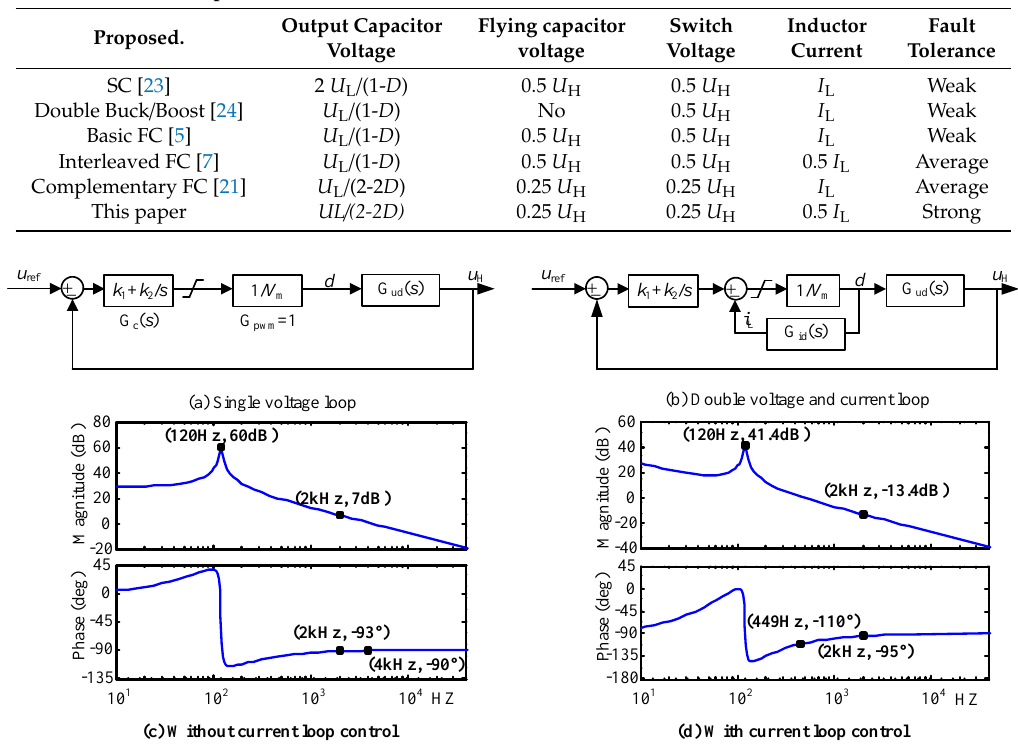
Figure 6. The control strategy. ( a ) & ( c ) are single voltage loop and its Bode without current loop control. ( b ) & ( d ) are double voltage-current loop and its Bode with current loop control.